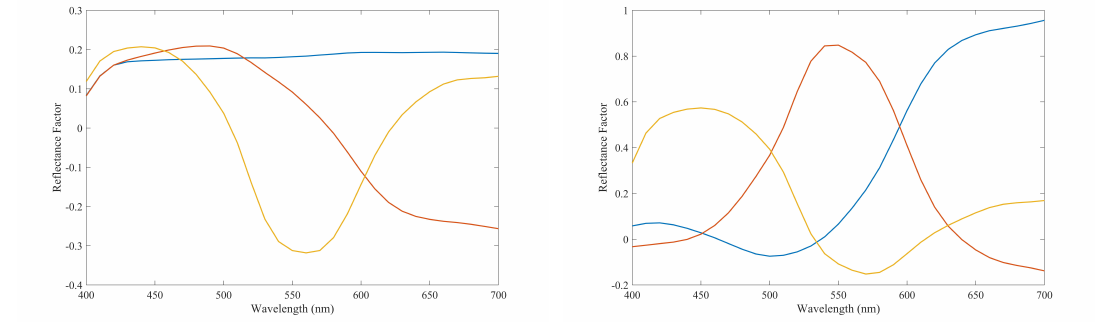
Figure 17. Base functions used by the PCA method ( left ) and Pseudo-Inverse method ( right